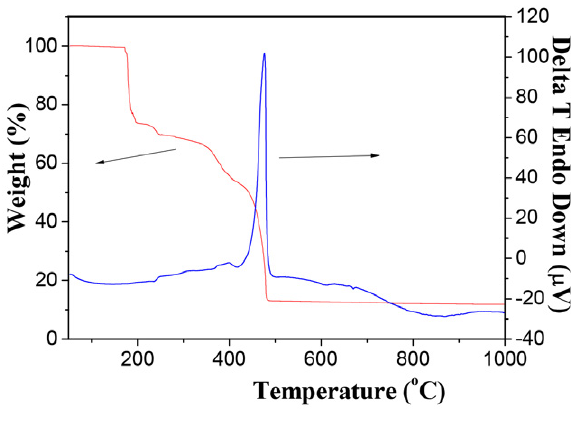
Figure 3. DT-TGA curves of complex 1 .